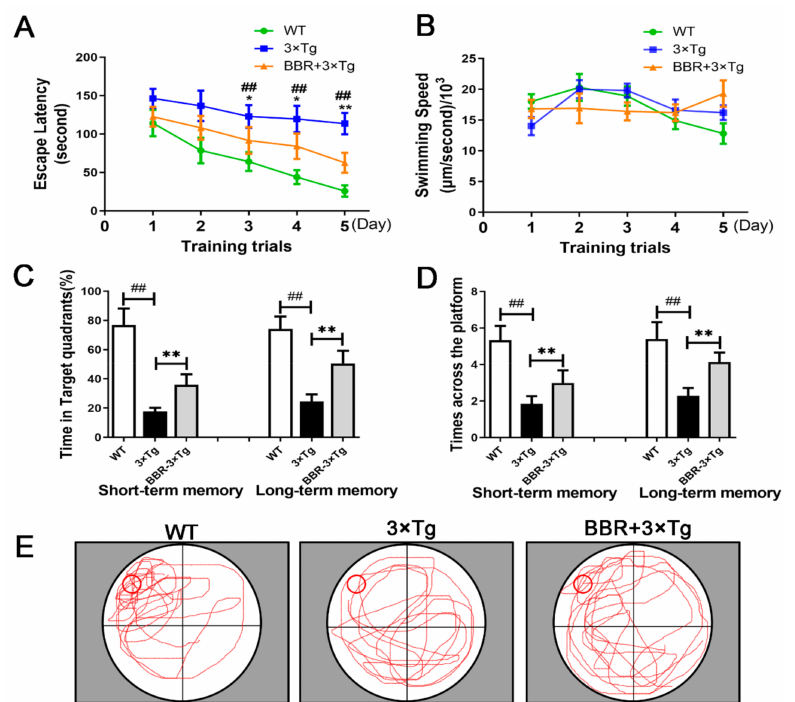
Figure 2. A Morris water maze task was used to evaluate the effect of berberine on the spatial learning and memory of 3 × Tg AD mice. ( A ) In five-day training trial, the escape latency of each mouse was measured. ( B ) There were no significant differences in swimming speed across the three groups. ( C ) In the probe trail, the frequency at which the mouse passed through the submerged platform placement area during the training trial was recorded. ( D ) Time spent searching for the pre-placed platform in the target quadrant, in both the short- and long-term memory tests. ( E ) The swimming tracks of the mice from the three groups made in the water tank on the last day of the test. WT, wild-type mice, 3 × Tg, 3 × Tg AD mice; BBR + 3 × Tg; 3 × Tg AD mice were given BBR at 100 mg/kg/day. One-way ANOVA and Dunnett’s post-hoc test were used to analyze all the data, which are presented as mean ± SD; n = 12 animals/group. * p < 0.05, ## p < 0.01, 3 × Tg AD group vs. WT group. * p < 0.05, ** p < 0.01, BBR treated 3 × Tg vs. 3 × Tg